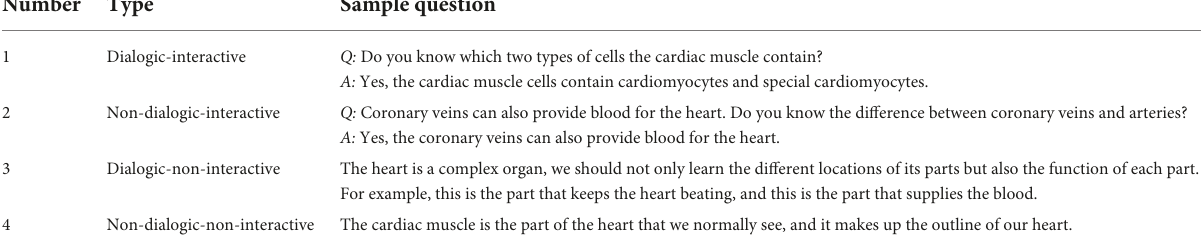
TABLE 1 Specific questions used to encourage social interaction: four classes of communicative approach.